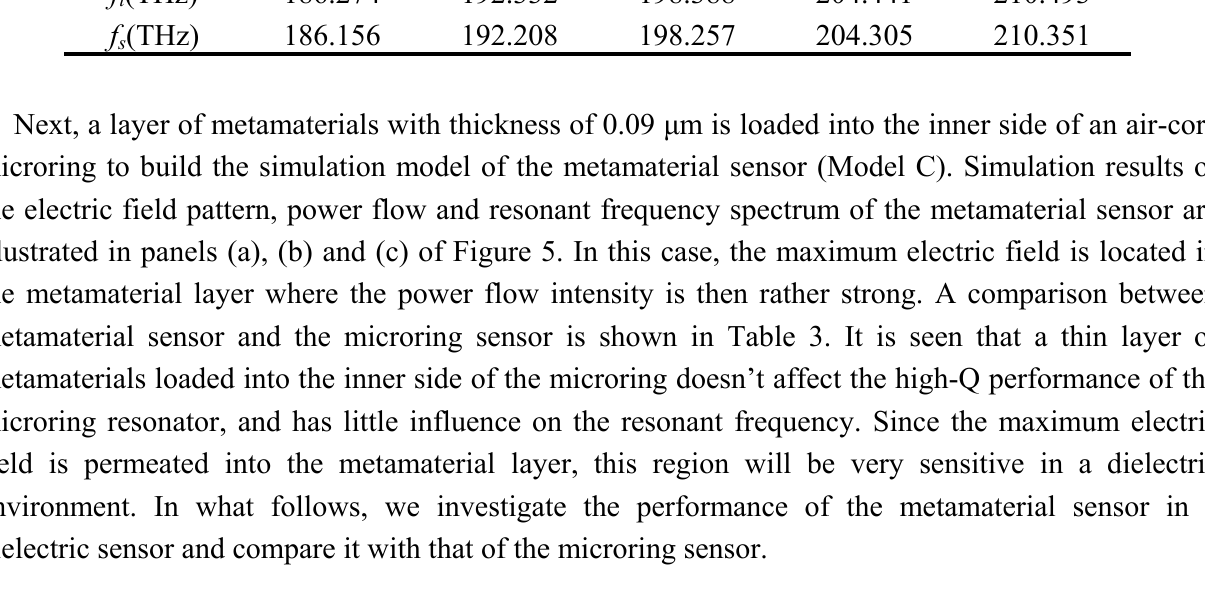
) and the simulated resonant t